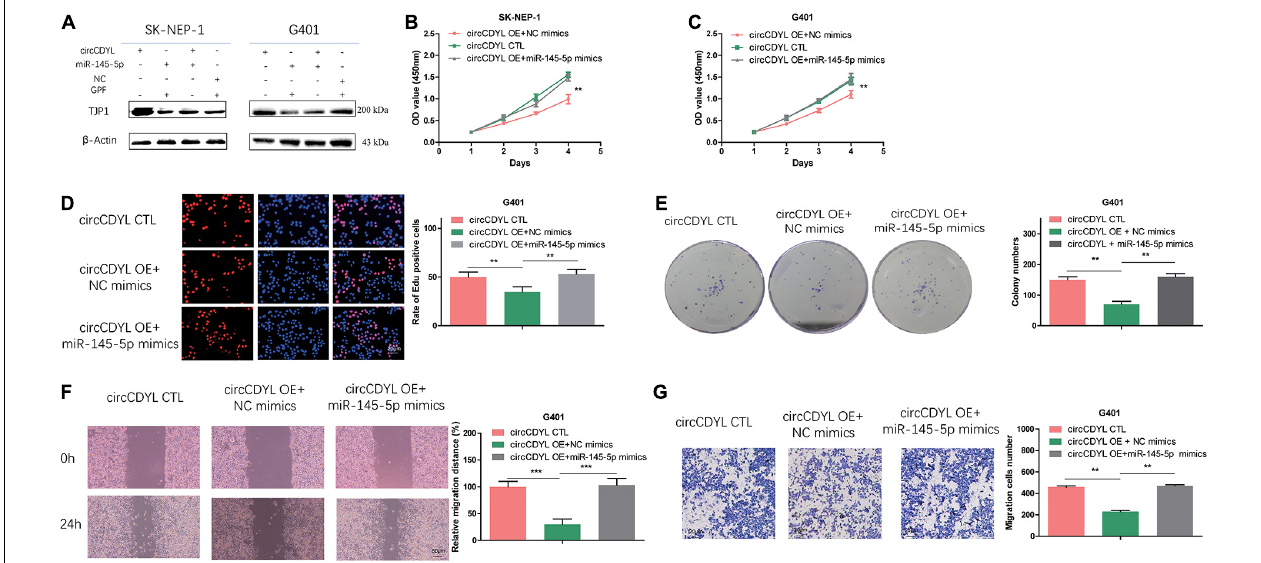
FIGURE 6 | MiR-145-5p can partially reverse the effect of circCDYL on proliferation, migration, and invasion in WT cells. (A) Co-transfection of miR-145-5p mimics and circCDYL to detect the protein levels of TJP1 in WT cell lines by Western blot. (B–G) Co-transfection of miR-145-5p mimics and circCDYL to investigate malignant transformation of cells by CCK-8 (B,C) , EdU (D) , colony formation (E) , wound healing (F) , and transwell (G) assays in the WT cell lines. Data represent the mean ± SD from three independent experiments. Student’s t -test with two biologically dependent or independent replicates was used to determine statistical significance; *** P < 0.001, ** P < 0.01, * P <